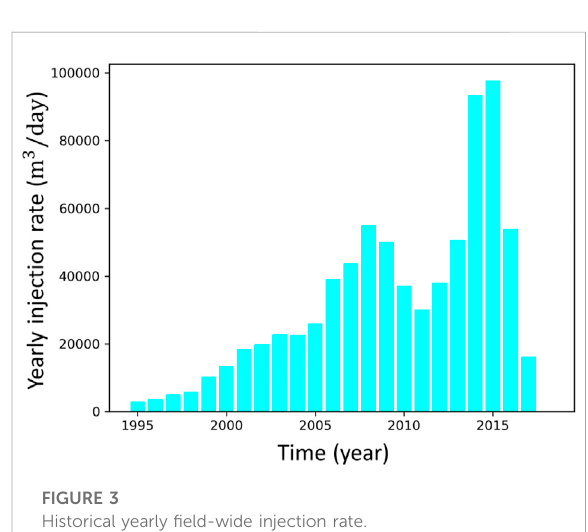
Historical yearly fi eld-wide injection